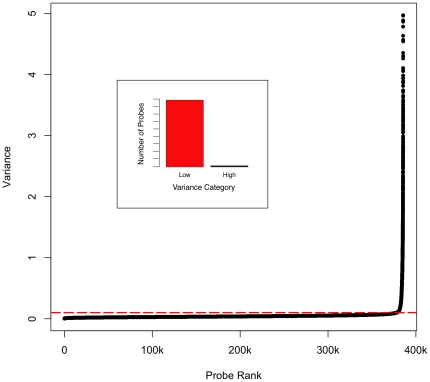
Observed variance in probe performance across multiple array CGH experiments.384,475 probes are ranked by variance in normalized log(2) ratios across 19 array CGH experiments. Rank order of probe is plotted on the x-axis, variance on the y-axis. A dotted horizontal line is drawn at variance  = 0.1, where probes are dichotomized according to “low” or “high” variance. Inset: number of probes that fall into each category.